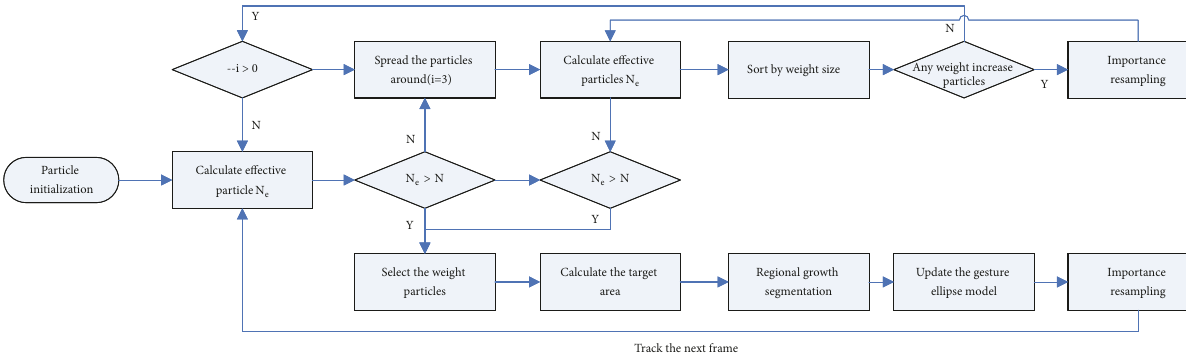
Figure 1: The algorithm flowchart with switching federated filter